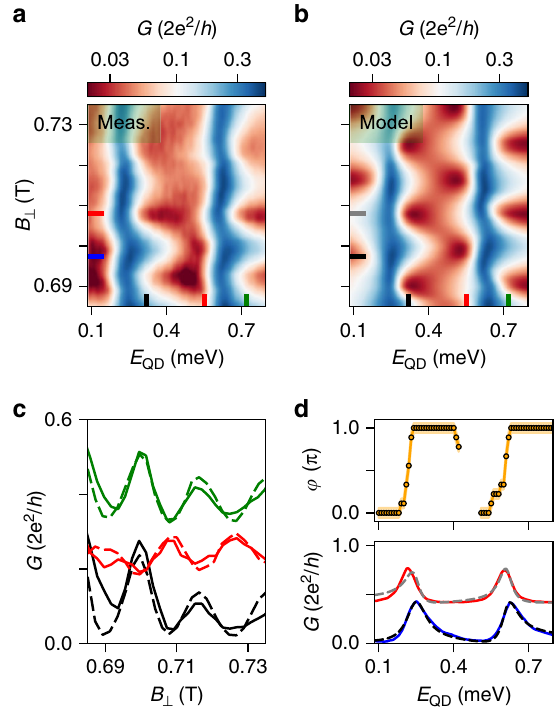
Fig. 4 The universal phase behaviour. a G versus E QD and B ⊥ at zero bias voltage, describing the evolution of two adjacent Coulomb peaks as a function of magnetic fi eld. Data are taken at back-gate voltage V B G = 1.5 V. b Fit of the data in ( a ). c Solid and dashed traces are vertical line-cuts from ( a ) and ( b ), respectively, indicated by black, red, and green lines. The three pairs of curves are displaced by an offset of 0.15 ⋅ 2 e 2 / h for clarity. d Bottom panel: solid and dashed lines are horizontal line-cuts of ( a ) and ( b ), respectively, at the positions indicated by the blue/black and red/grey lines. Top panel: transmission phase φ extracted from the AB pattern. The shaded region indicates the error bars that stem from the uncertainty in extracting the oscillation maxima that is ~1 − 2